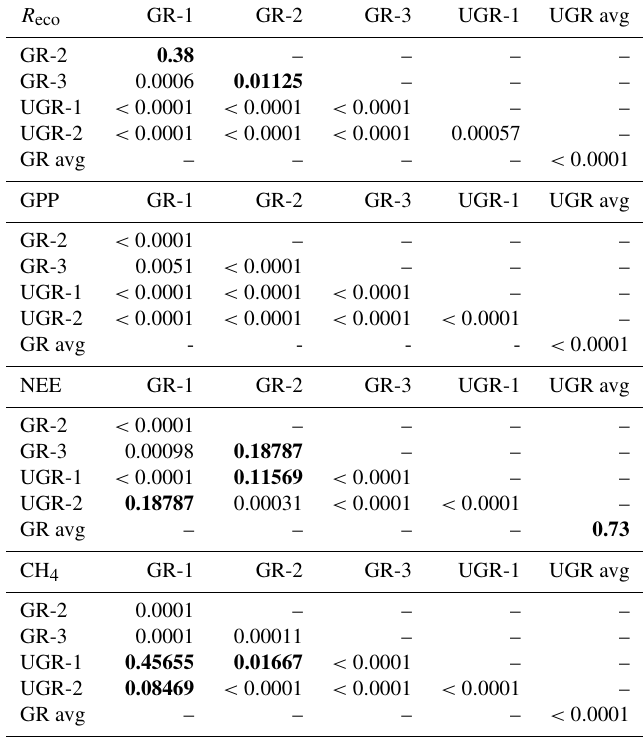
Table B3. Corrected p values (insignificant values – above 0.01 – marked bold) of pairwise t tests applied to daily means of modeled fluxes at all sites over the whole observation period. UGR avg and GR avg were compared separately.